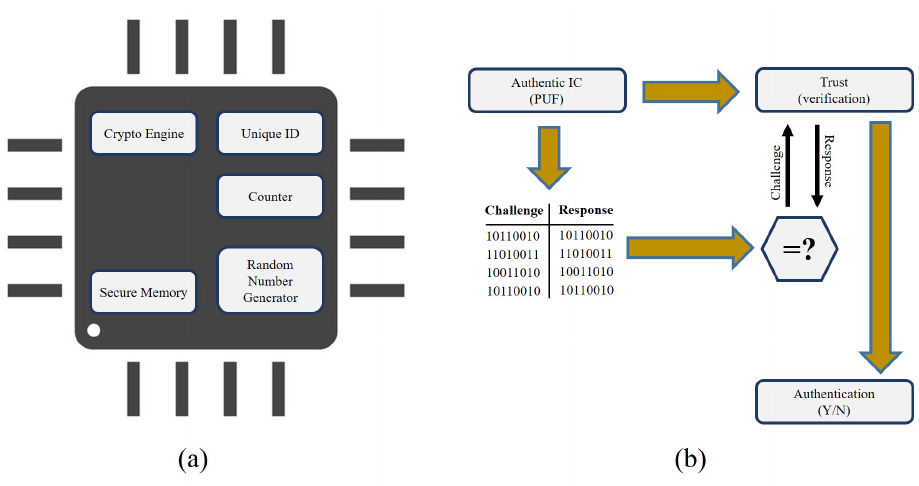
Figure 6. ( a ) Basic design and ( b ) authentication process of Physical Unclonable Function (PUF)